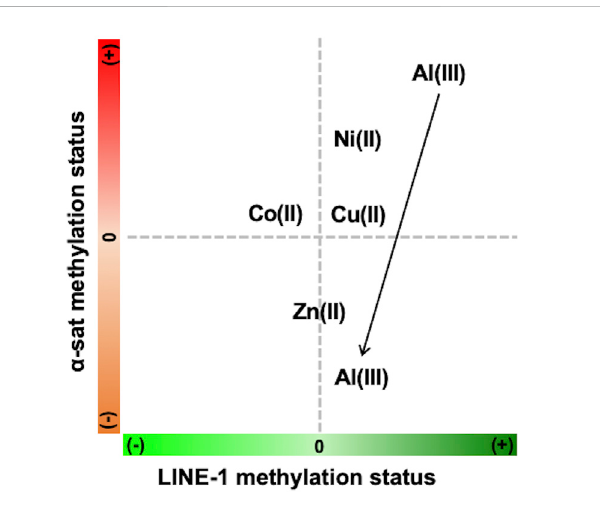
FIGURE 7 Summary of the concentration-dependent effects of various metals on LINE-1 and α -sat methylation status (+) refers to hypermethylation, and ( − ) refers to hypomethylation. The arrow indicates the increase of metal